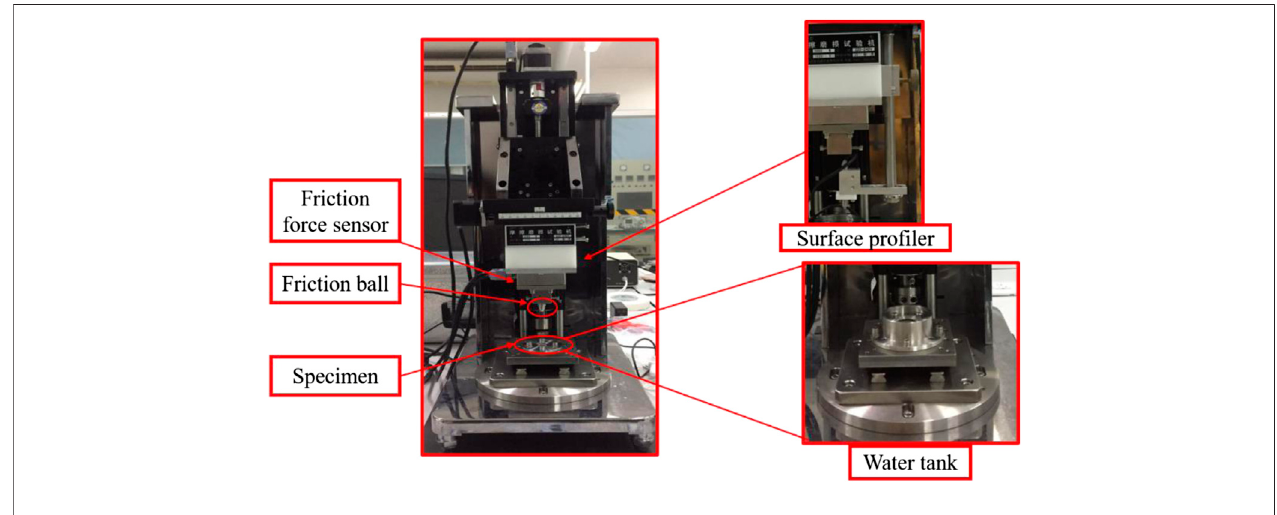
FIGURE 1 | CFT-I type friction wear testing machine.